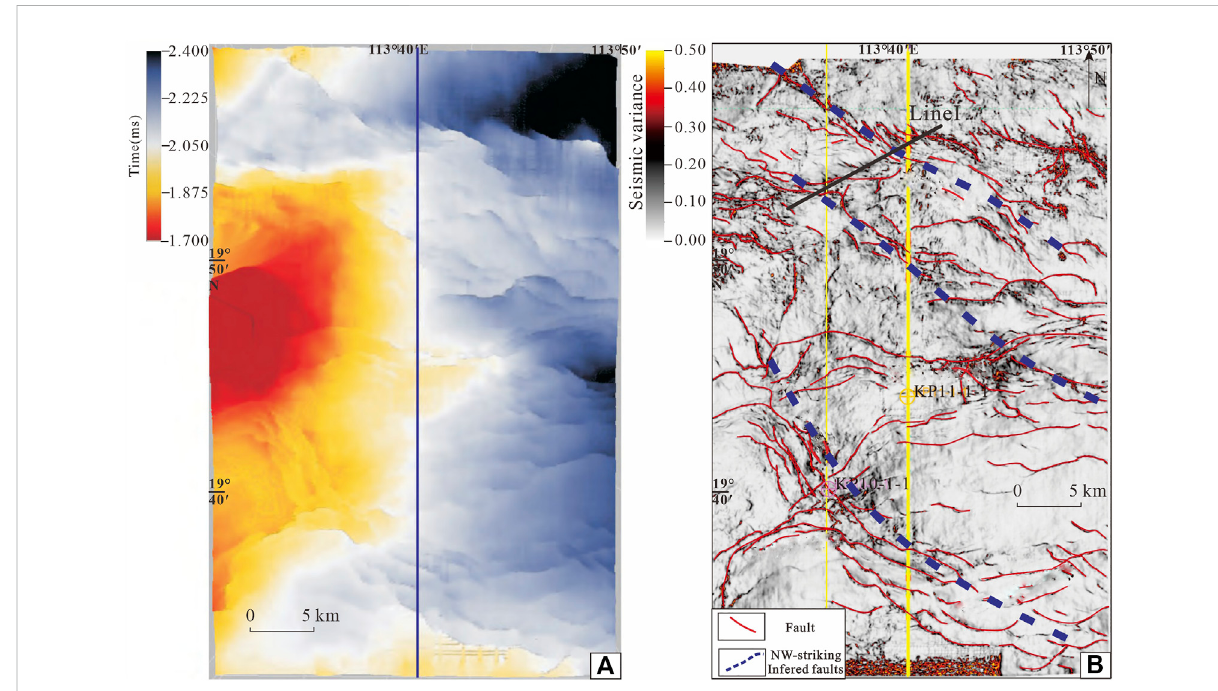
FIGURE 7 Distribution characteristics offault plane combinationalong T 70 inthe northeasternpart of the Kaiping Sag (Figure2 shows fi gurelocation). (A) . T